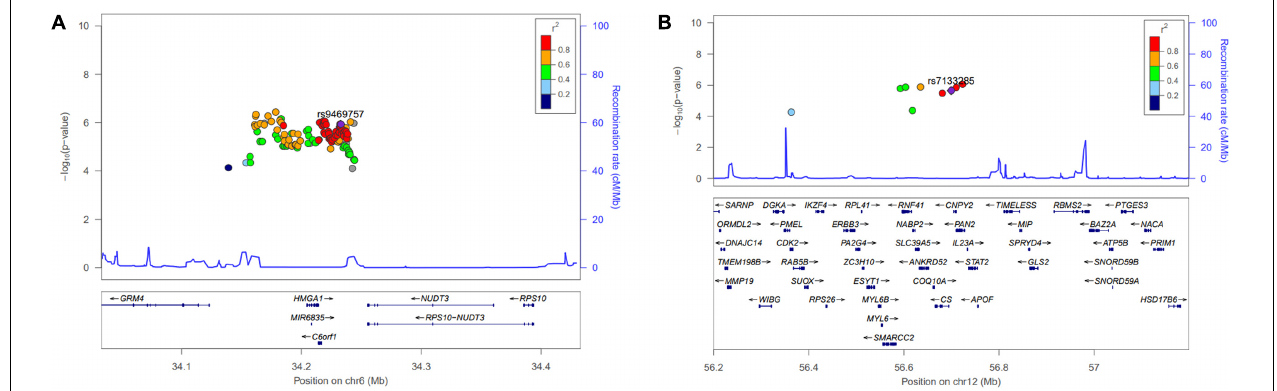
FIGURE 1 | Regional association plot for the newly identified single-nucleotide polymorphisms (SNPs). Height-related signals in the discovery genome-wide association studies are plotted as –log 10 P values. The color of each SNP plot shows its linkage disequilibrium (using r 2 values) with the novel SNP (purple diamond) within the association locus. The y -axis on the right shows the recombination rate from the HapMap database. The image above was constructed using the LocusZoom program (http://locuszoom.org/). (A) Regional plot of rs9469757 ( P = 1.16 × 10 − 6 ) around the RP11-513I15.6 region of chromosome 6 with height in women. (B) Regional plot of rs7133285 ( P = 2.25 × 10 − 6 ) around the RP11-977G19.10 region of chromosome